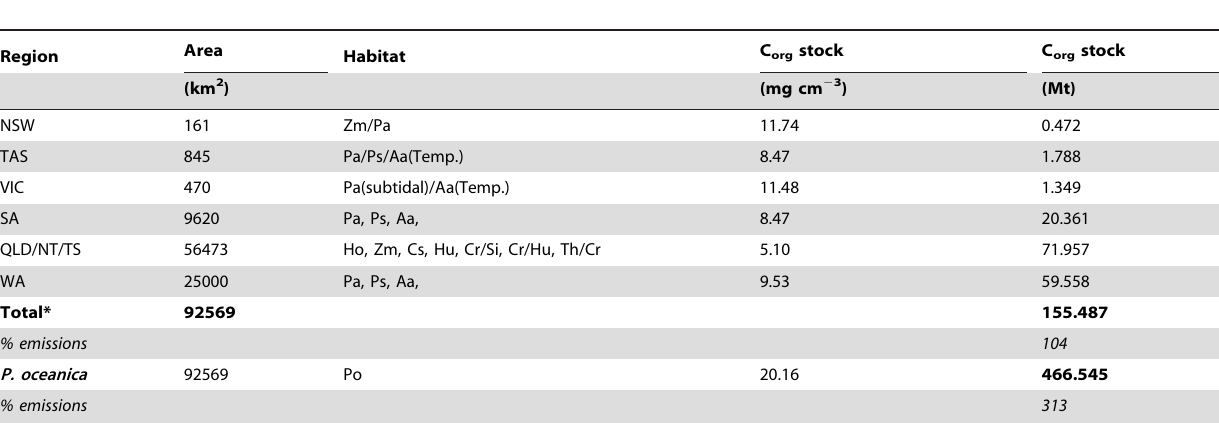
Table 6. Carbon storage in the top 25 cm of Australian seagrass ecosystems and those that would be estimated by applying the carbon storage values of P. oceanica to the same area of